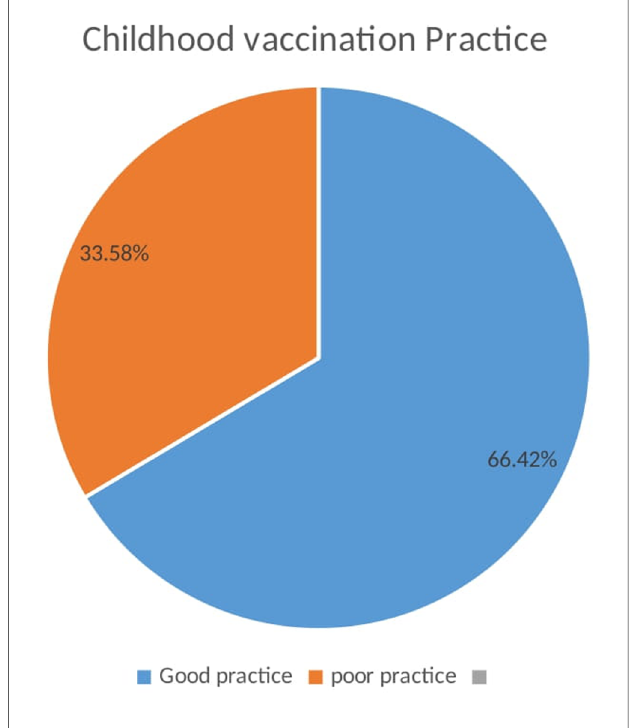
FIGURE 2 Childhood vaccination practices among mothers/caregivers in Debre Tabor, Northwest Ethiopia, 2022 ( n